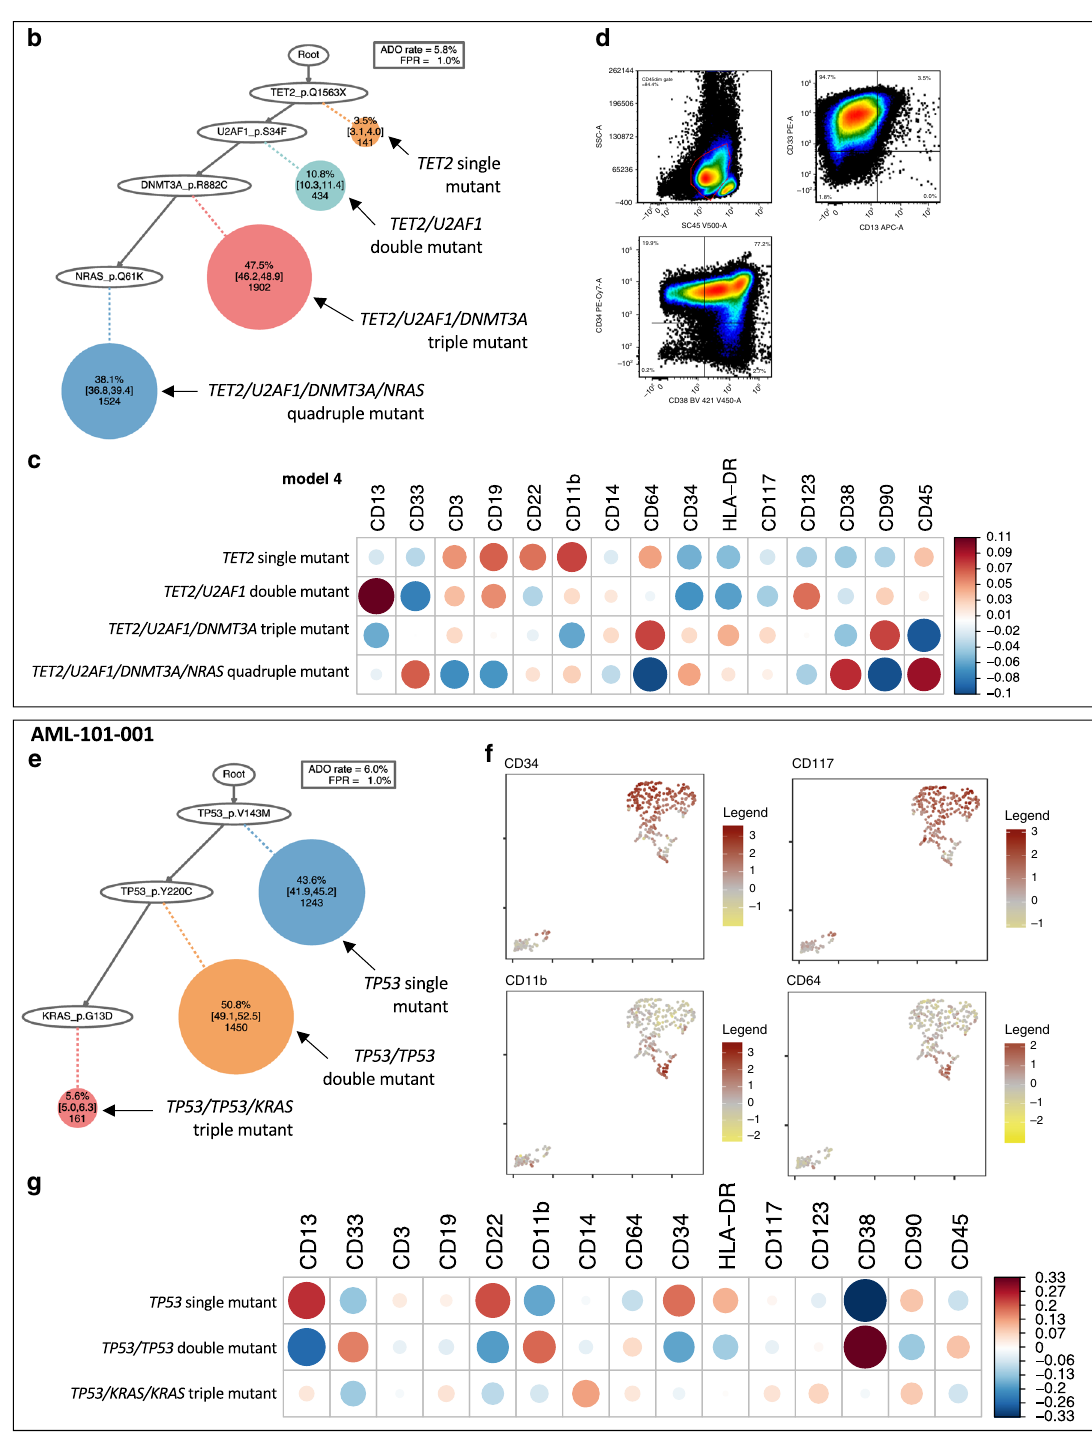
Fig. 5 The single-cell genotype – phenotype correlation. a A heat map showing the cellular-level correlation between immunophenotype and genotype based on the entire sequenced cells. Each circle is colored by the r value of coef fi cient (red if positively correlated and blue if negatively correlated), with the size re fl ecting the absolute r value (* r < 0.05, ** r < 0.01, *** r < 0.001). b – d A representative case (AML-103-001) showing a stepwise mutation acquisition along with hematopoietic differentiation. b SCITE-inferred model 2 phylogeny tree showing a linear evolution pattern of driver mutations. c A heat map showing the immunophenotype of each genotype-de fi ned subclone shown in Fig. 5b. d Flow cytometry data from the same patient. A cellular population delineated with a red line indicates CD45-dim cells. The blasts were CD34 + CD33 + CD13 - myeloblasts. A subset of CD34 + blasts showed CD38 expression. Detailed fl ow cytometry data is available in Supplementary Fig. 13c, d. e – g A representative case (AML-101-001) showing two distinct blasts populations determined by the simultaneous single-cell DNA and protein pro fi ling. e SCITE-inferred model 2 phylogeny tree showing a linear evolution pattern. f The single-cell immunophenotyping data for selected cell surface markers. Each dot represents a sequenced cell. Relative expression of each cell surface marker is normalized by the degree of the logarithmic odds ratio (log OR, brown if high expression, yellow if low expression). g A heat map showing the immunophenotype of each genotype-de fi ned subclone determined by the SCITE model from Fig. 5e. ADO allele dropout, FPR false-positive